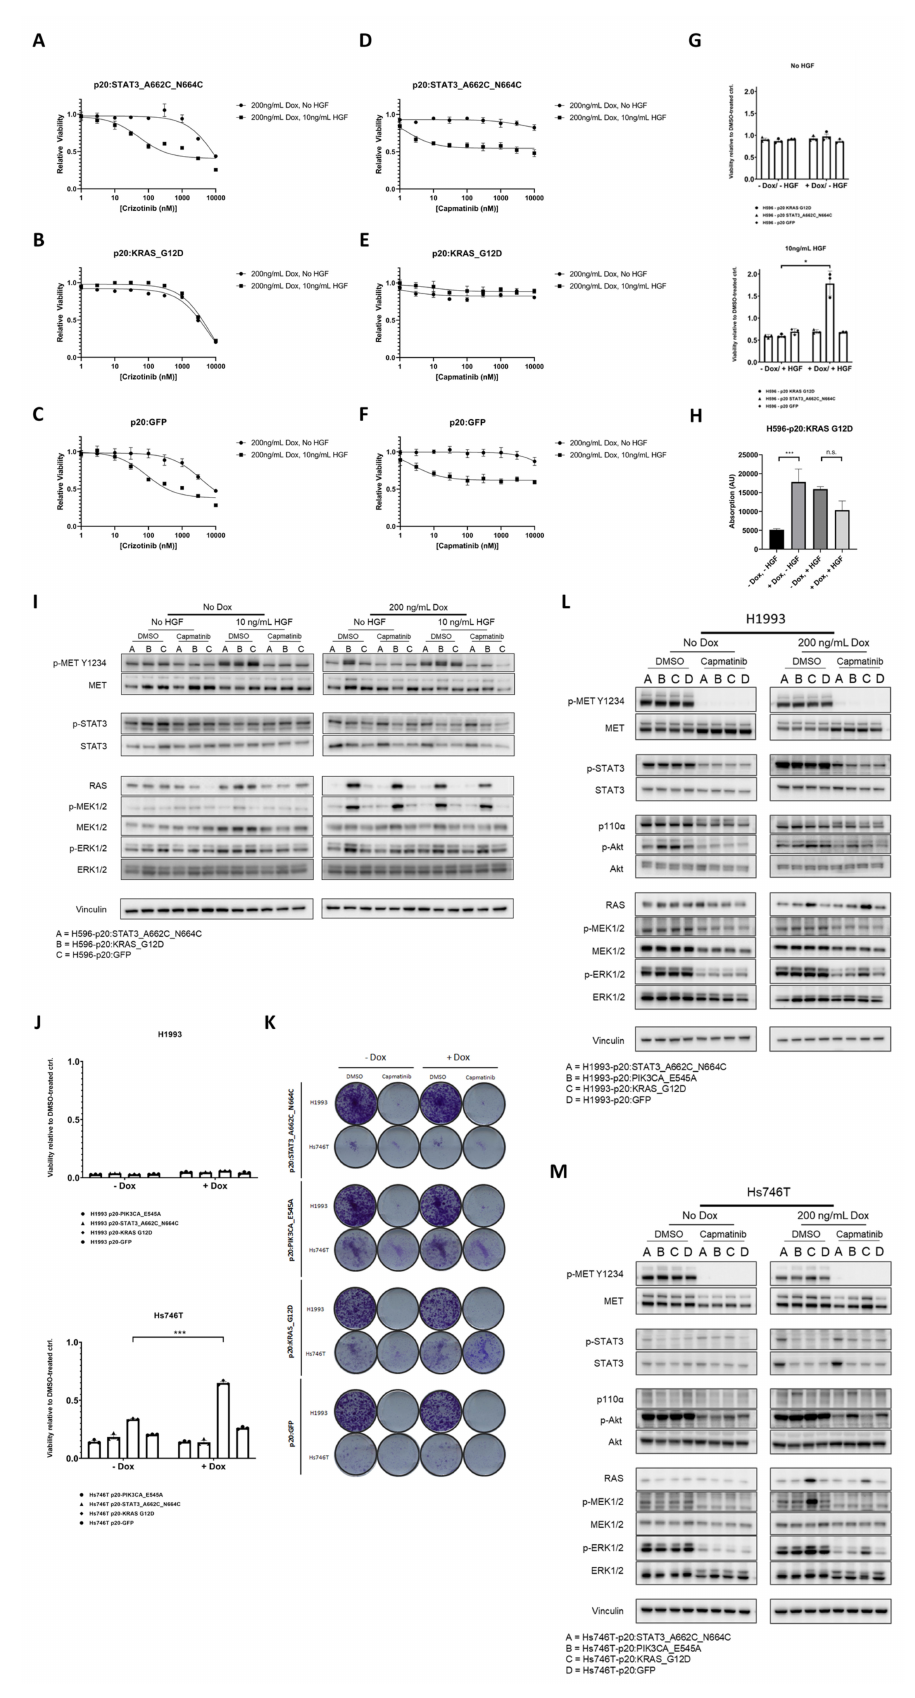
Figure 5. Decoupling MET from the Ras/MAPK pathway is sufficient to rescue cell death